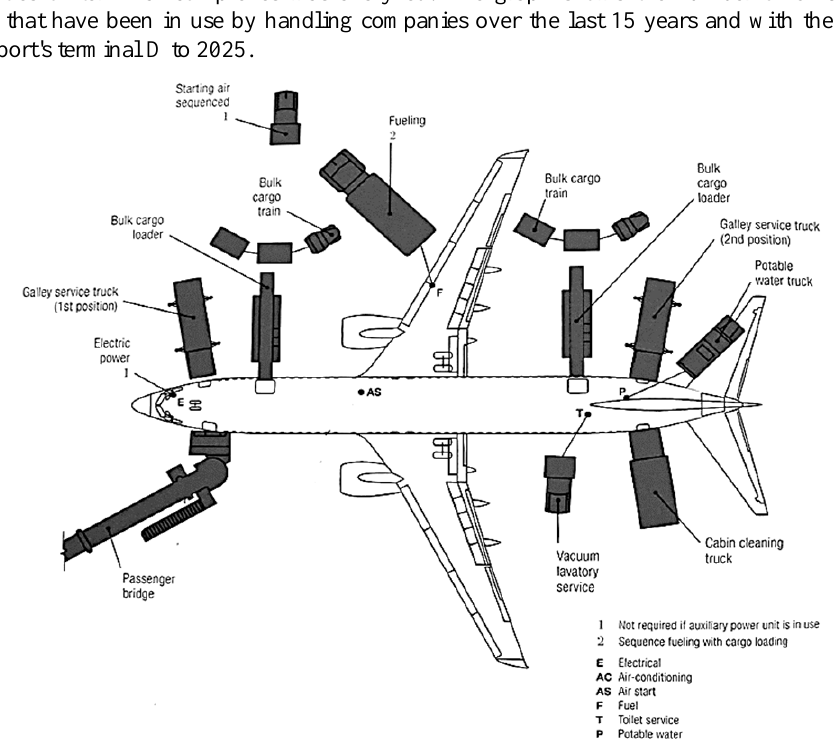
Fig. 1. Scheme of ground maintenance of the B737